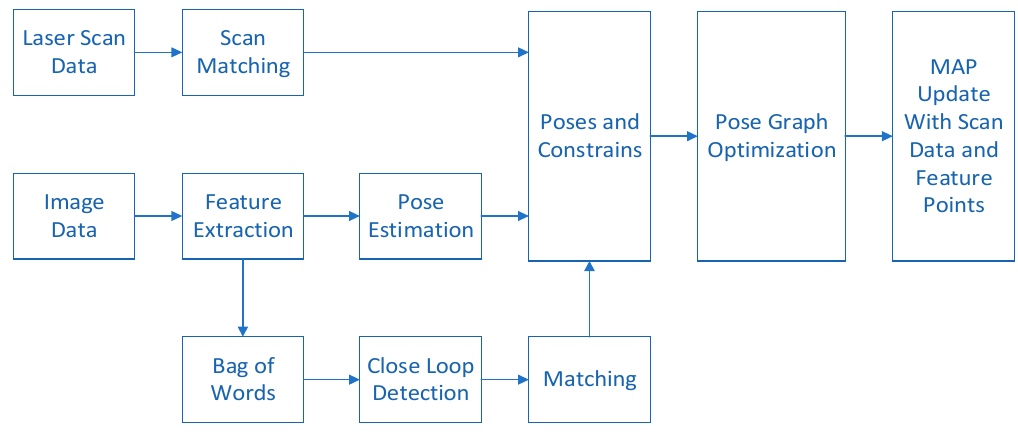
Figure 4. The proposed SLAM framework.